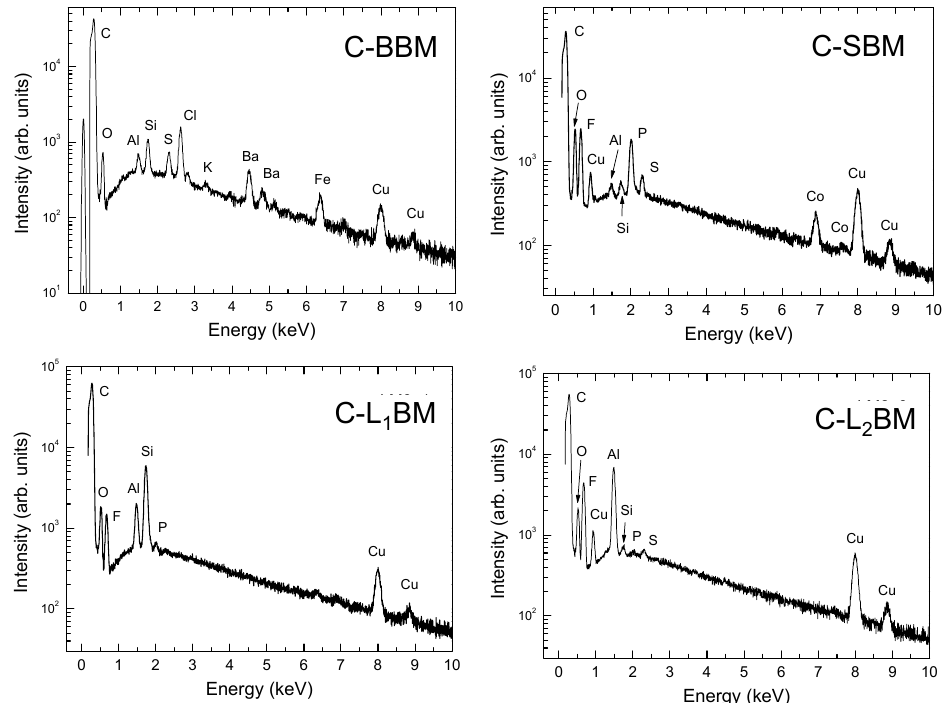
Figure 3. Representative EDX spectra of the investigated graphite samples.